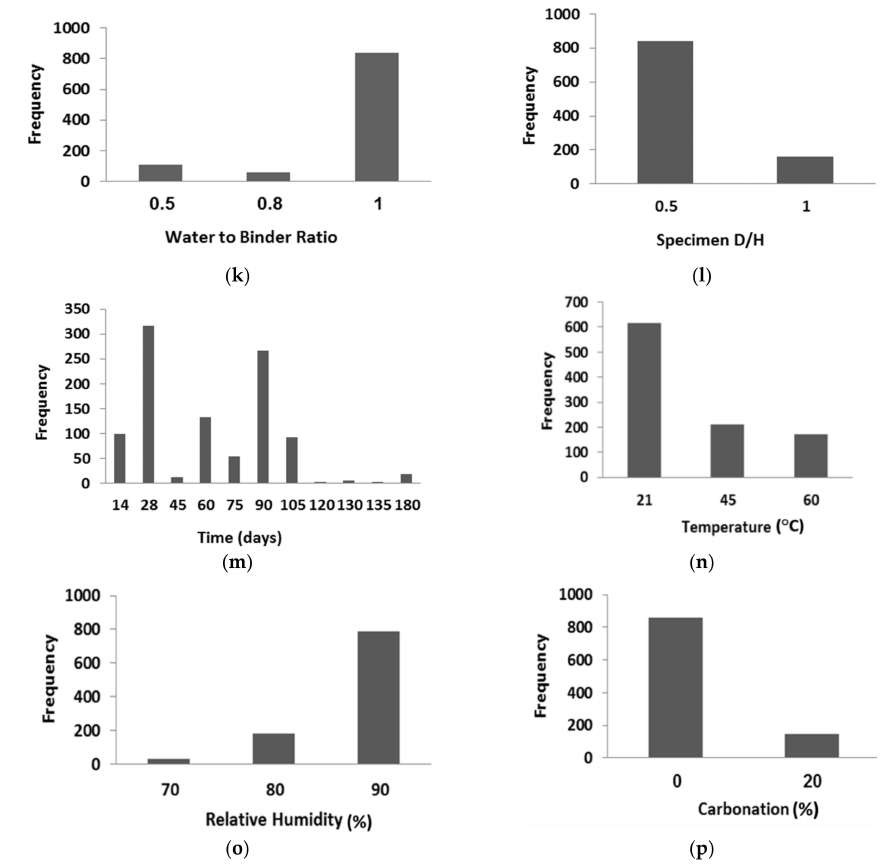
Figure 8. Histograms of number of tests performed according to each control variable: ( a ) Organic Content of Soil (OC), ( b ) Water Content of Soil (w), ( c ) Ratio of Binder for Portland cement (RB- PC ), ( d ) Ratio of Binder for Blast Furnace Slag (RB-BFS), ( e ) Ratio of Binder for Pulverized Fuel Ash (RB-PFA), ( f ) Ratio of Binder for Lime (RB-L), ( g ) Ratio of Binder for Magnesium Oxide (RB-MgO-C), ( h ) Ratio of Binder for Gypsum (RB-G), ( i ) Quantity of Binder (QB), ( j ) Grout to Soil Ratio (G/S), ( k ) Water to Binder ratio (W/B), ( l ) Specimen Diameter/Height (D/H), ( m ) Time (t), ( n ) Temperature (T), ( o ) Relative Humidity (RH), and ( p ) Carbonation ( CO 2 ).